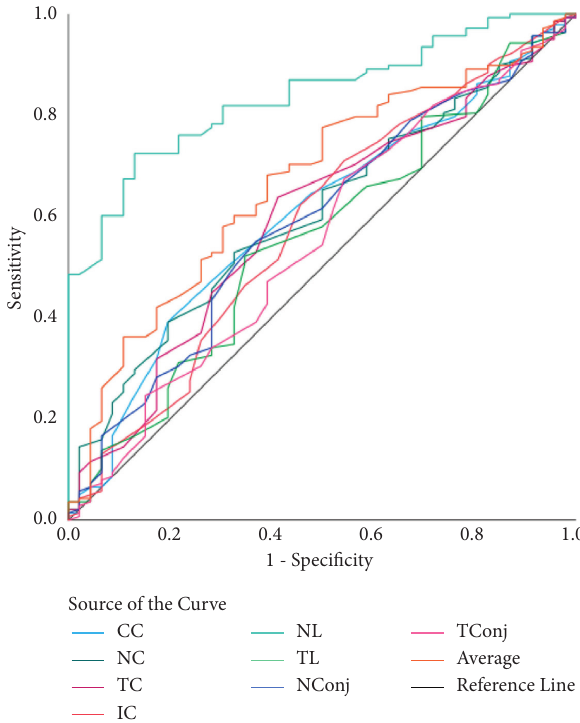
Figure 5: ROC curves of ocular surface temperature for severe dry eye disease. ROC curves represent the severe dry eye disease group vs. nondry eye, mild dry eye, and moderate dry eye groups. Table 4: Correlation between ROI and DED severity. ROI Pearson correlation